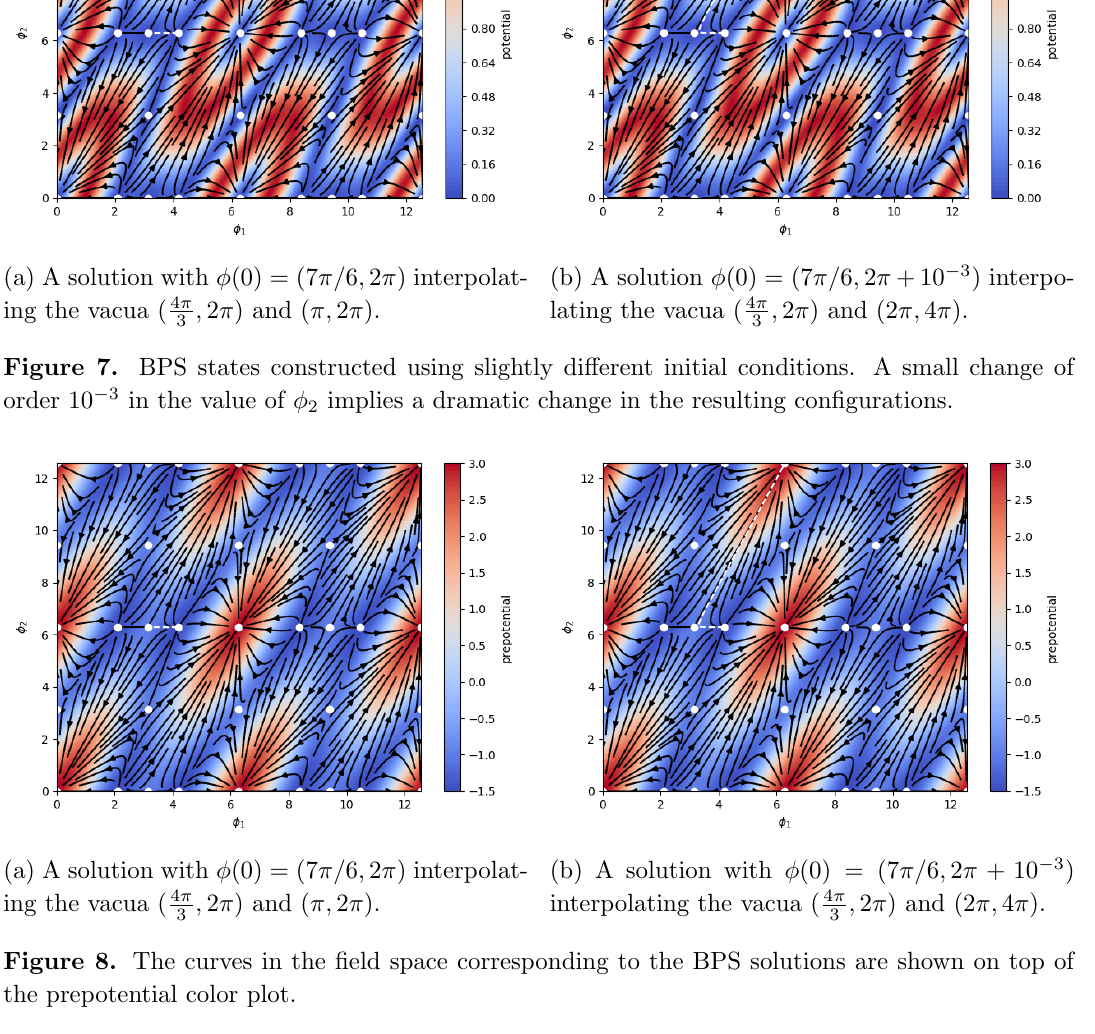
(a) A solution with (cid:30) (0) = (7 (cid:25)= 6 ; 2 (cid:25) ) interpolat- ing the vacua ( 4 (cid:25) ; 2 (cid:25) ) and ( (cid:25); 2 (cid:25) ). 3 Figure 8. The curves in the (cid:12)eld space corresponding to the BPS solutions are shown on top of the prepotential color